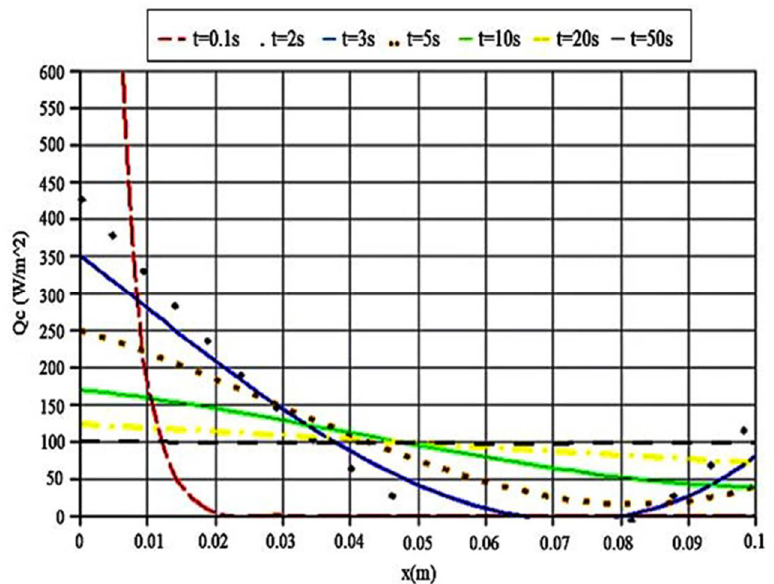
Figure 5. Conductive heat flux in various time steps.